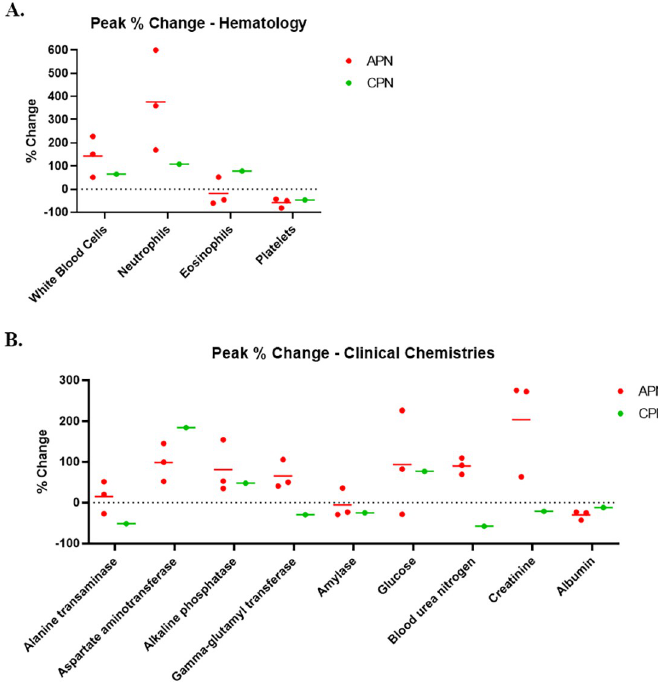
Fig 2. Percent change in hematology and clinical chemistry parameters. The percent change from baseline was determined for each animal for hematology and clinical chemistry parameters. Shown in this figure are peak percent change values for APN (red) and CPN (green) for relevant hematology (A) and clinical chemistry (B) parameters.